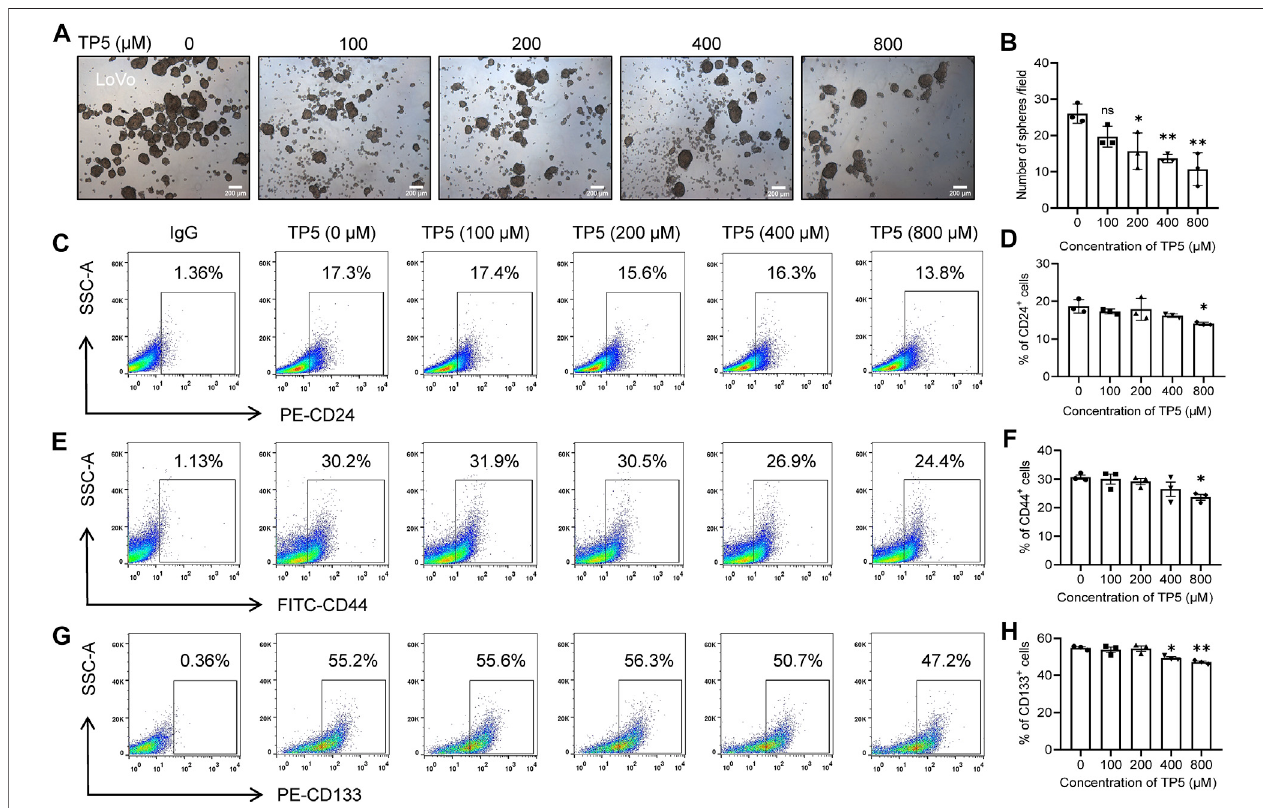
FIGURE 2 | TP5 inhibits the stemness of cancer stem cells in LoVo cells. (A, B) Representative photomicrographs of sphere formation experiments (A) and statistical analysis of the number of spheres with diameter ≥ 140 μ m in visual fi eld (B) . LoVo cells were incubated with different treatments of TP5 (0, 100, 200, 400, and 800 μ M) and grown in serum-free medium for 6 days. Scale bar = 200 μ m. (C – H) Flow cytometer analysis of the expression of CD24, CD44 or CD133 (C, E, G) and pooled data of cell surface markers CD24 (D) , CD44 (F) and CD133 (H) ( n = 3 independent experiments). All data are expressed as mean ± SD; * p < 0.05, ** p < 0.01 versus control, one-way ANOVA with Dunnett ’ s post-hoc test, (B) , [F (4, 10) = 8.484, p = 0.0030], (D) , [F (4, 10) = 3.795, p = 0.0397], (F) , [F (4, 10) = 3.397 p = 0.0531], (H) , [F (4, 10) = 11.09, p =